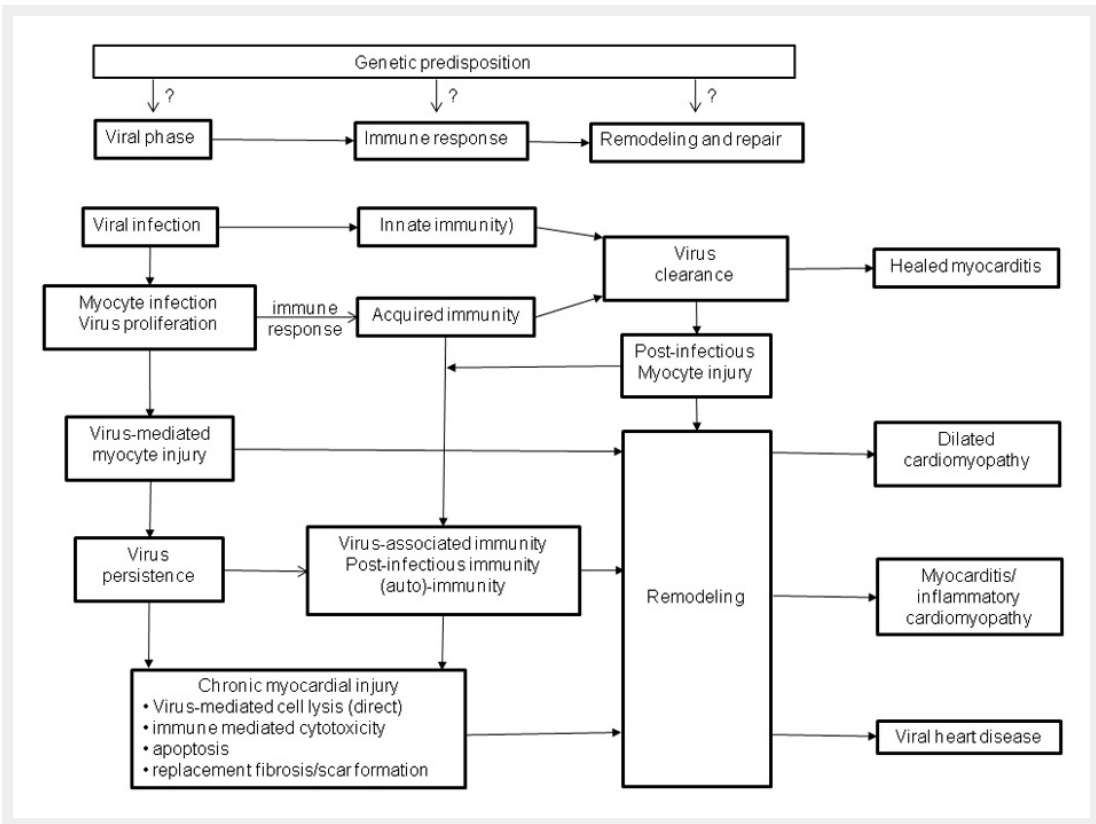
Figure 2 Three phase model of cardiovascular infection: A genetic predisposition is supposed (?) for some viruses but currently not proven. During the viral phase, infected cardiomyocytes become injured and the virus may persist due to an inadequate immune response. A regularly mounted immune response (phase 2) eliminates the viral infection and may further damage the myocardium if it declines improperly. Post-infectious, post-inflammatory immunity and preceding myocardial damage may stimulate ongoing tissue remodelling (phase 3) which affects cardiac function in the long run despite clearance of the initial causes.